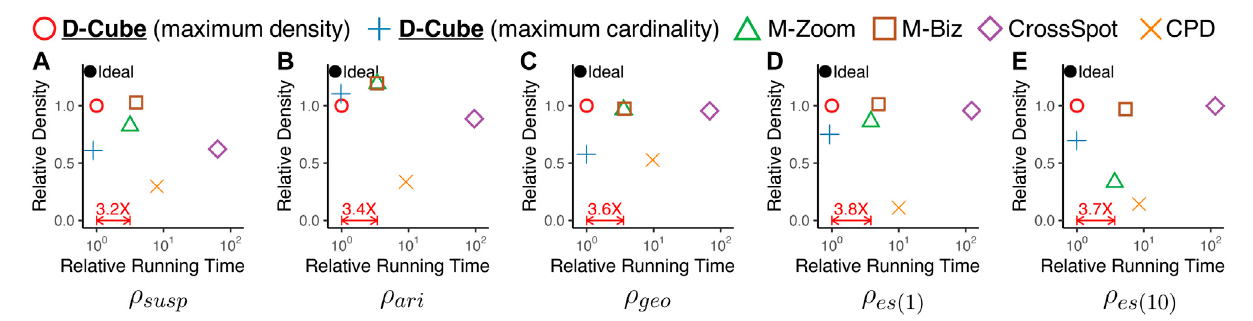
FIGURE4| D-CUBE rapidlyandaccuratelydetectsdensesubtensors.Ineachplot,pointsindicatethethedensitiesofsubtensorsdetectedbydifferentmethodsand their running times, averaged over all considered real-world tensors. Upper-left region indicates better performance. D-CUBE is about 3.6 × faster than the second